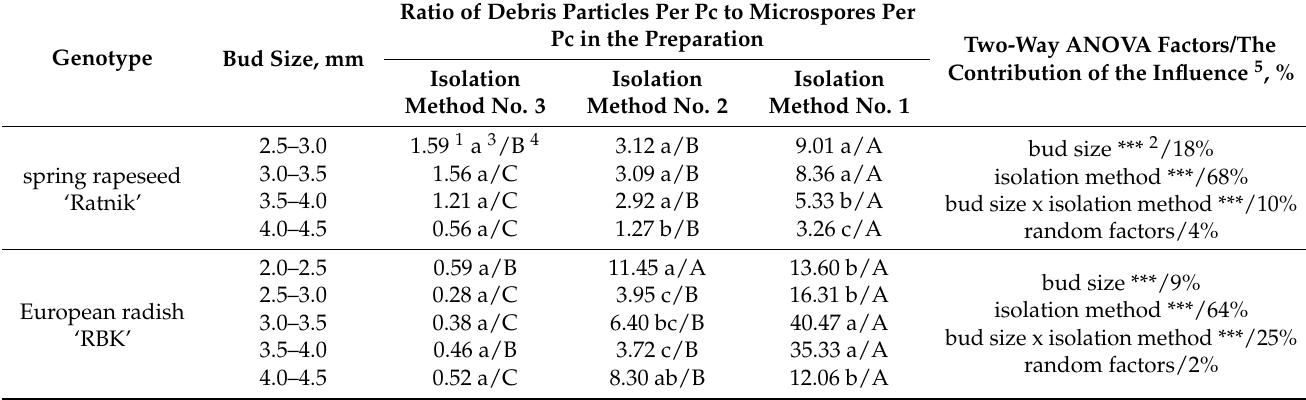
Table 2. Debris contamination of microspore culture preparations depending on the method of microspore isolation, linear size of buds, and genotype on the first day of